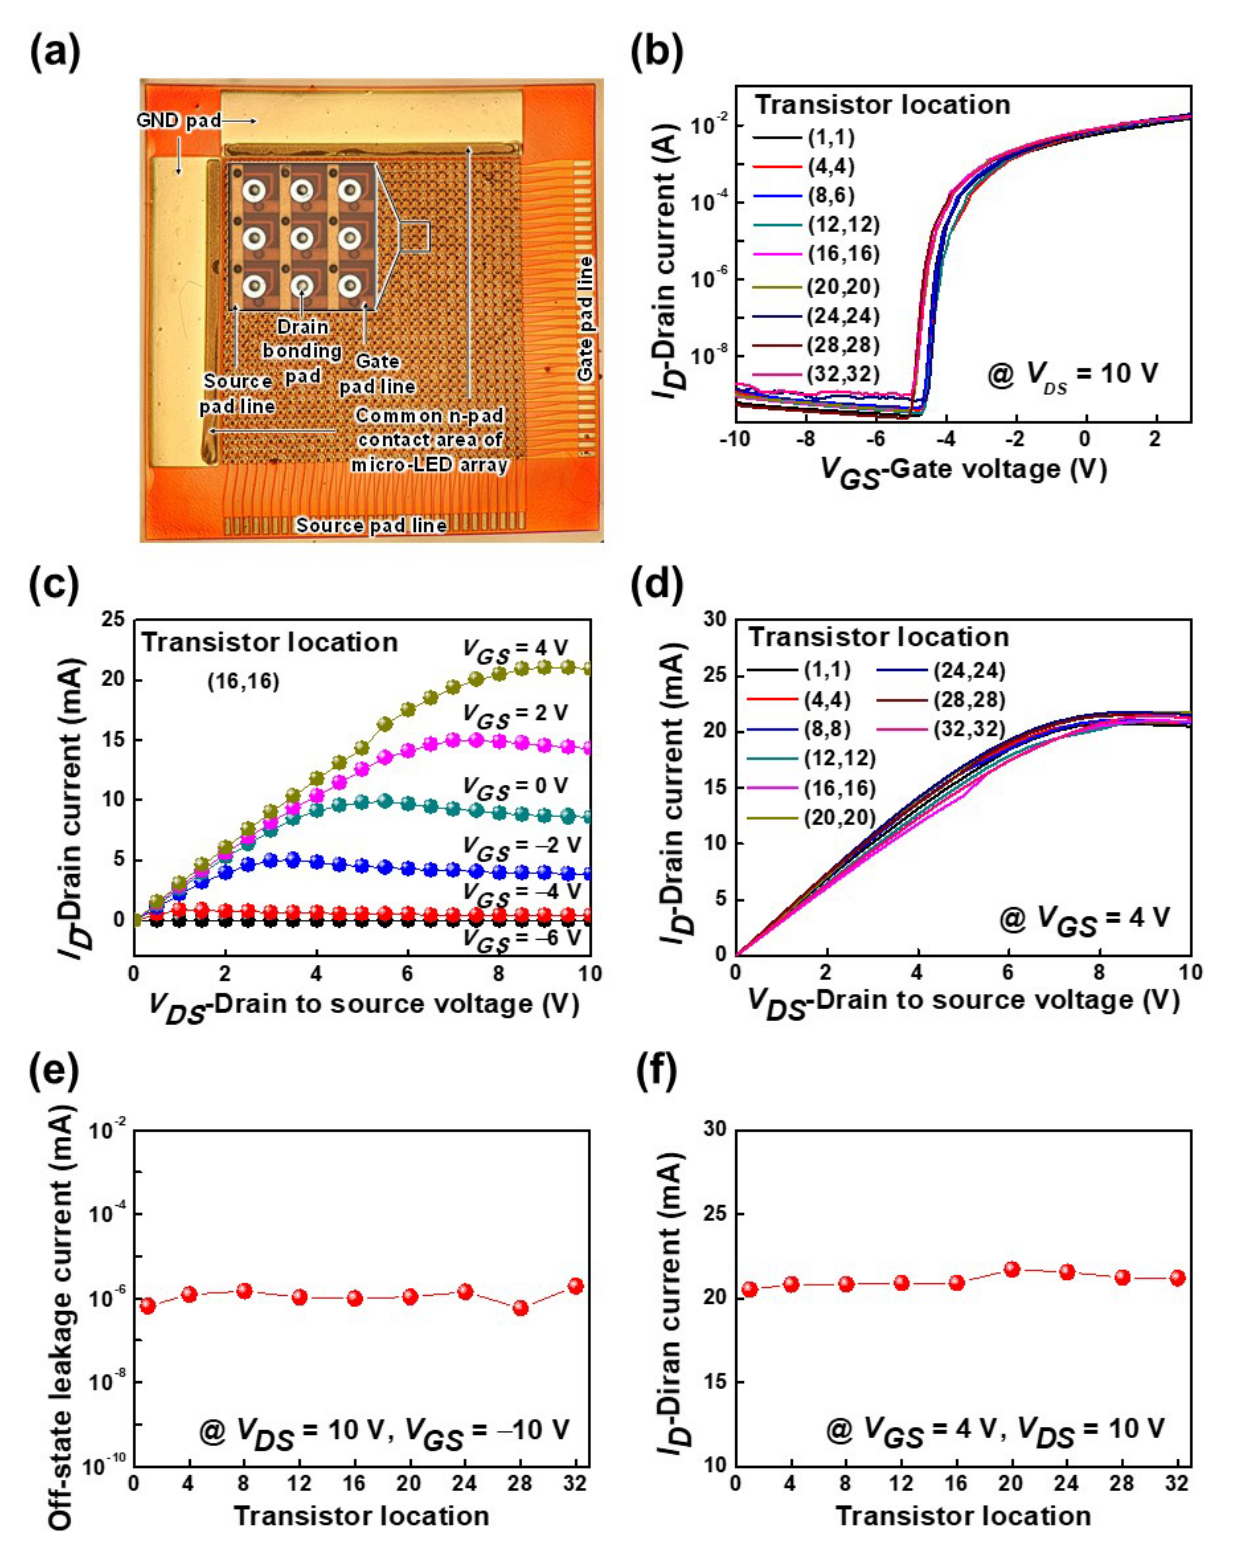
Figure 4. ( a ) Optical microscope image of 32 × 32 pixelated HEMT arrays. ( b ) Transfer characteristics of HEMT arrays for different pixel positions at V DS = 10 V. ( c ) Output characteristics for pixel location (16,16). ( d ) I D characteristics of HEMT arrays for different pixel locations at V GS = 4 V. ( e ) Off-state leakage current for different pixel locations at V GS = − 10 V and V DS = 10 V. ( f ) Drain current for different pixel locations at V GS = 4 V and V DS = 10 V.